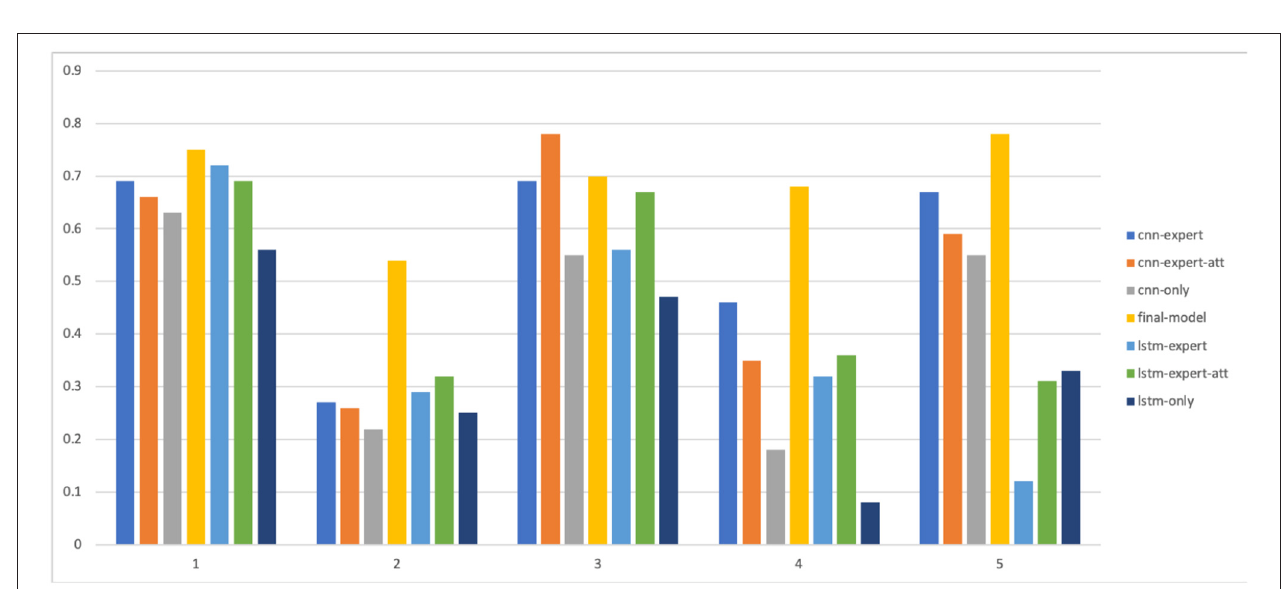
FIGURE 9 | F1-score of all the models for each